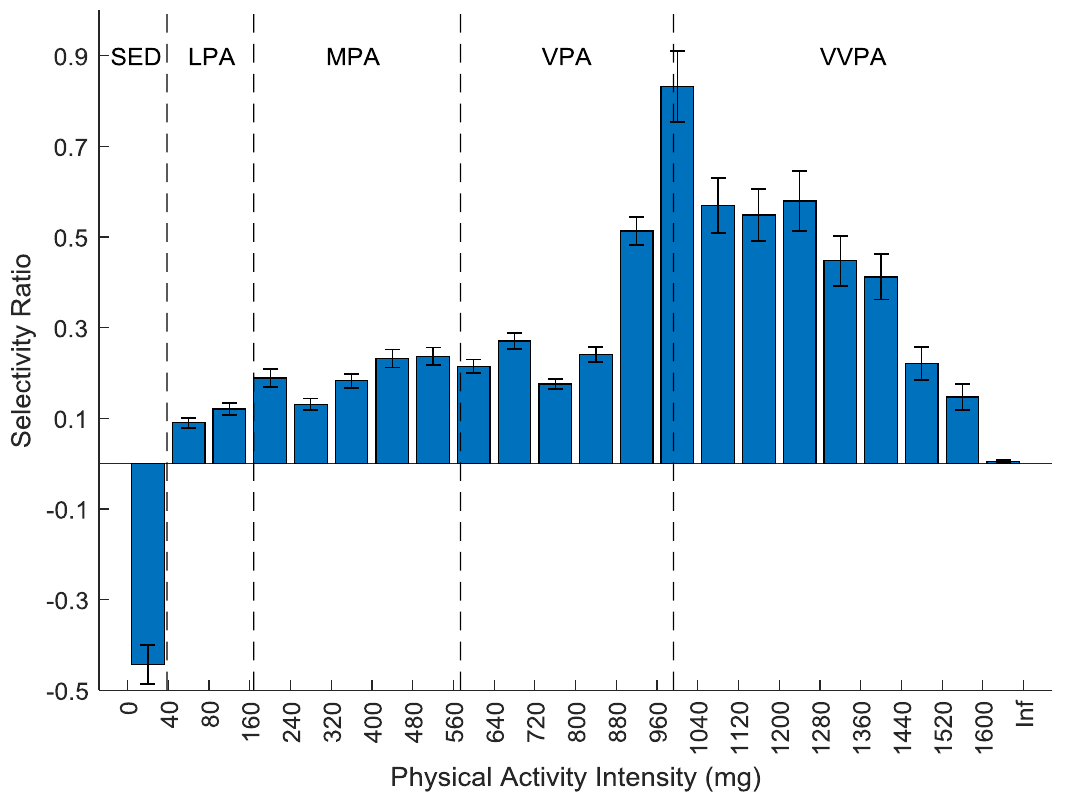
Figure 3. Selectivity ratio plot with confidence intervals of the association between each physical activity intensity variable (bin) using the 10 Hz filter and the cardiometabolic health composite store (CS). A positive bar indicates more time spent at that intensity is associated with higher CS and a negative bar indicates more time spent at that intensity is associated with lower CS. Traditional intensity classification as reference; SED, sedentary; LPA, light physical activity; MPA, moderate physical activity; VPA, vigorous physical activity; VVPA, very vigorous physical activity; Inf, infinity.